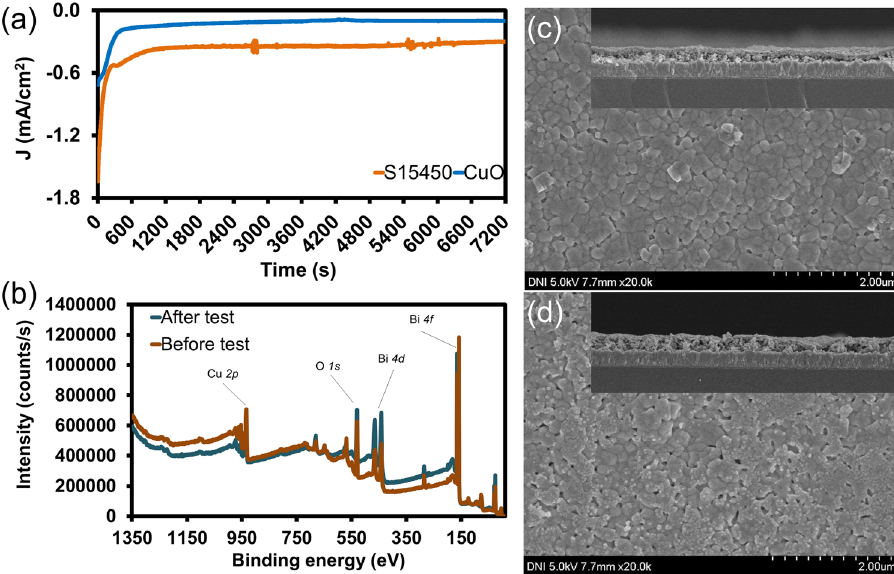
Figure 7. ( a ) Stability test on FTO/CuO and S15450 (FTO/CuO/CuBi 2 O 4 ) photocathodes under 7200 s of illumination (0.1 M